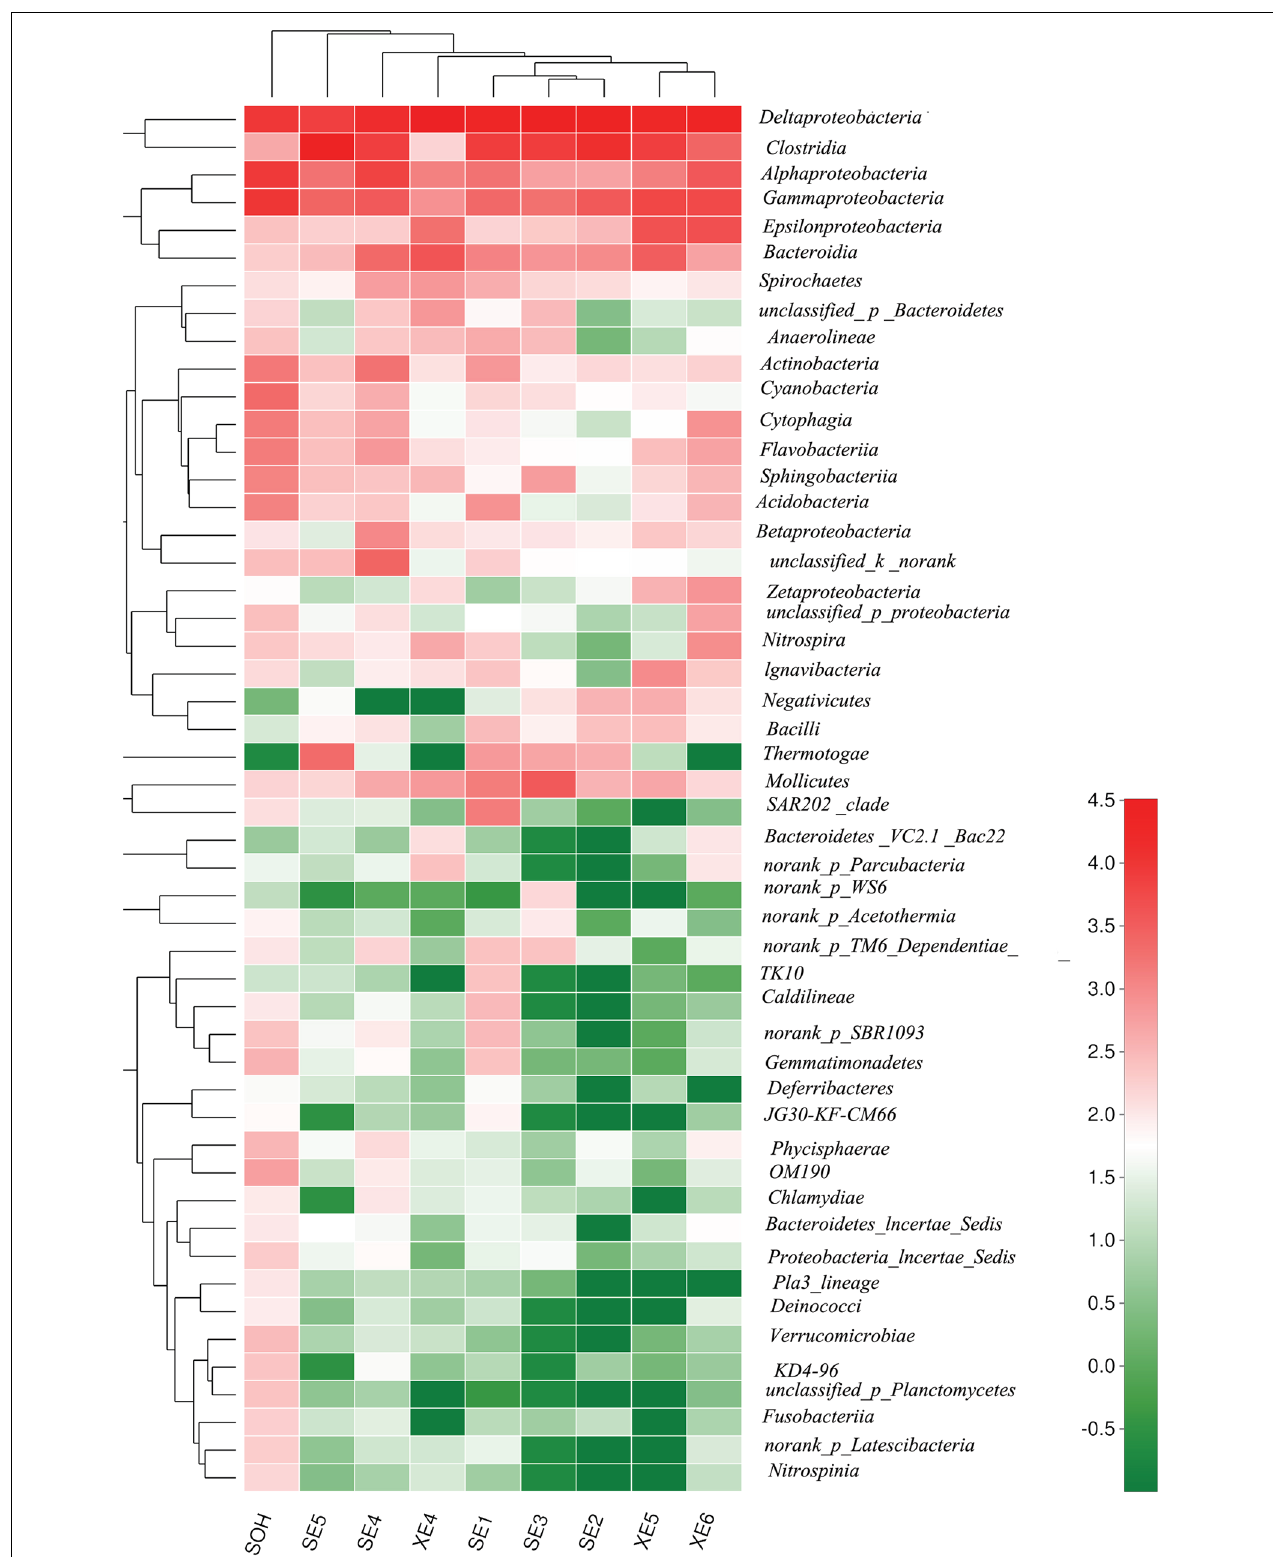
FIGURE 6 | The bacterial community distributions among the nine corrosion samples at the class level.